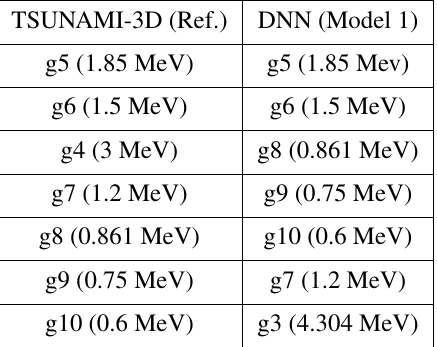
Table 3: Comparison of importance ranking of the fast fission cross-section energy groups ( Σ g ) based on sensitivity coefficients from TSUNAMI-3D (adjoint) and DNN f